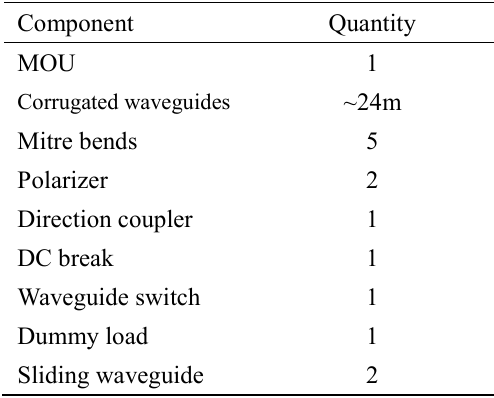
Table 4 . Compositions of a transmission line.